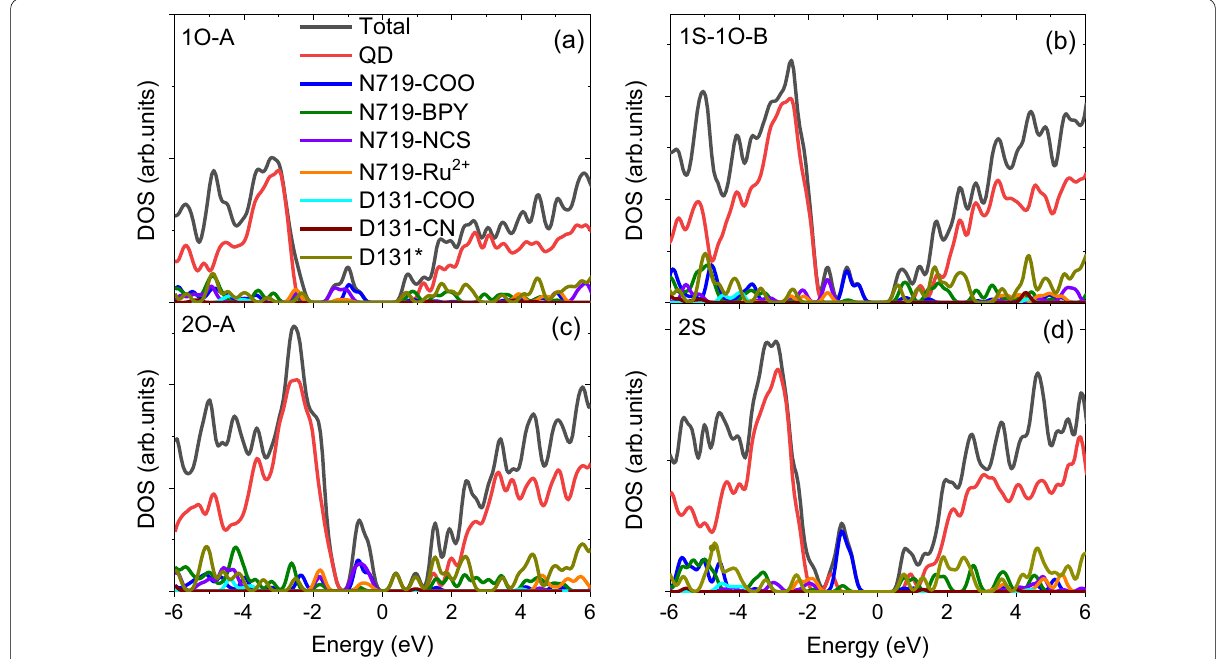
Fig. 3 PDOS of the selected binding geometries of N719 dye attached to the Cd 33 Se 33 QD@D131 dye composite in vacuum. The red, green, olive, violet, orange, cyan, wine, and dark yellow lines represent the contributions of molecular fragments associated with the Cd 33 Se 33 QD and N719 and D131 dyes. D131* denotes the molecular component from D131 dye, excluding the carboxylate and isocyanate